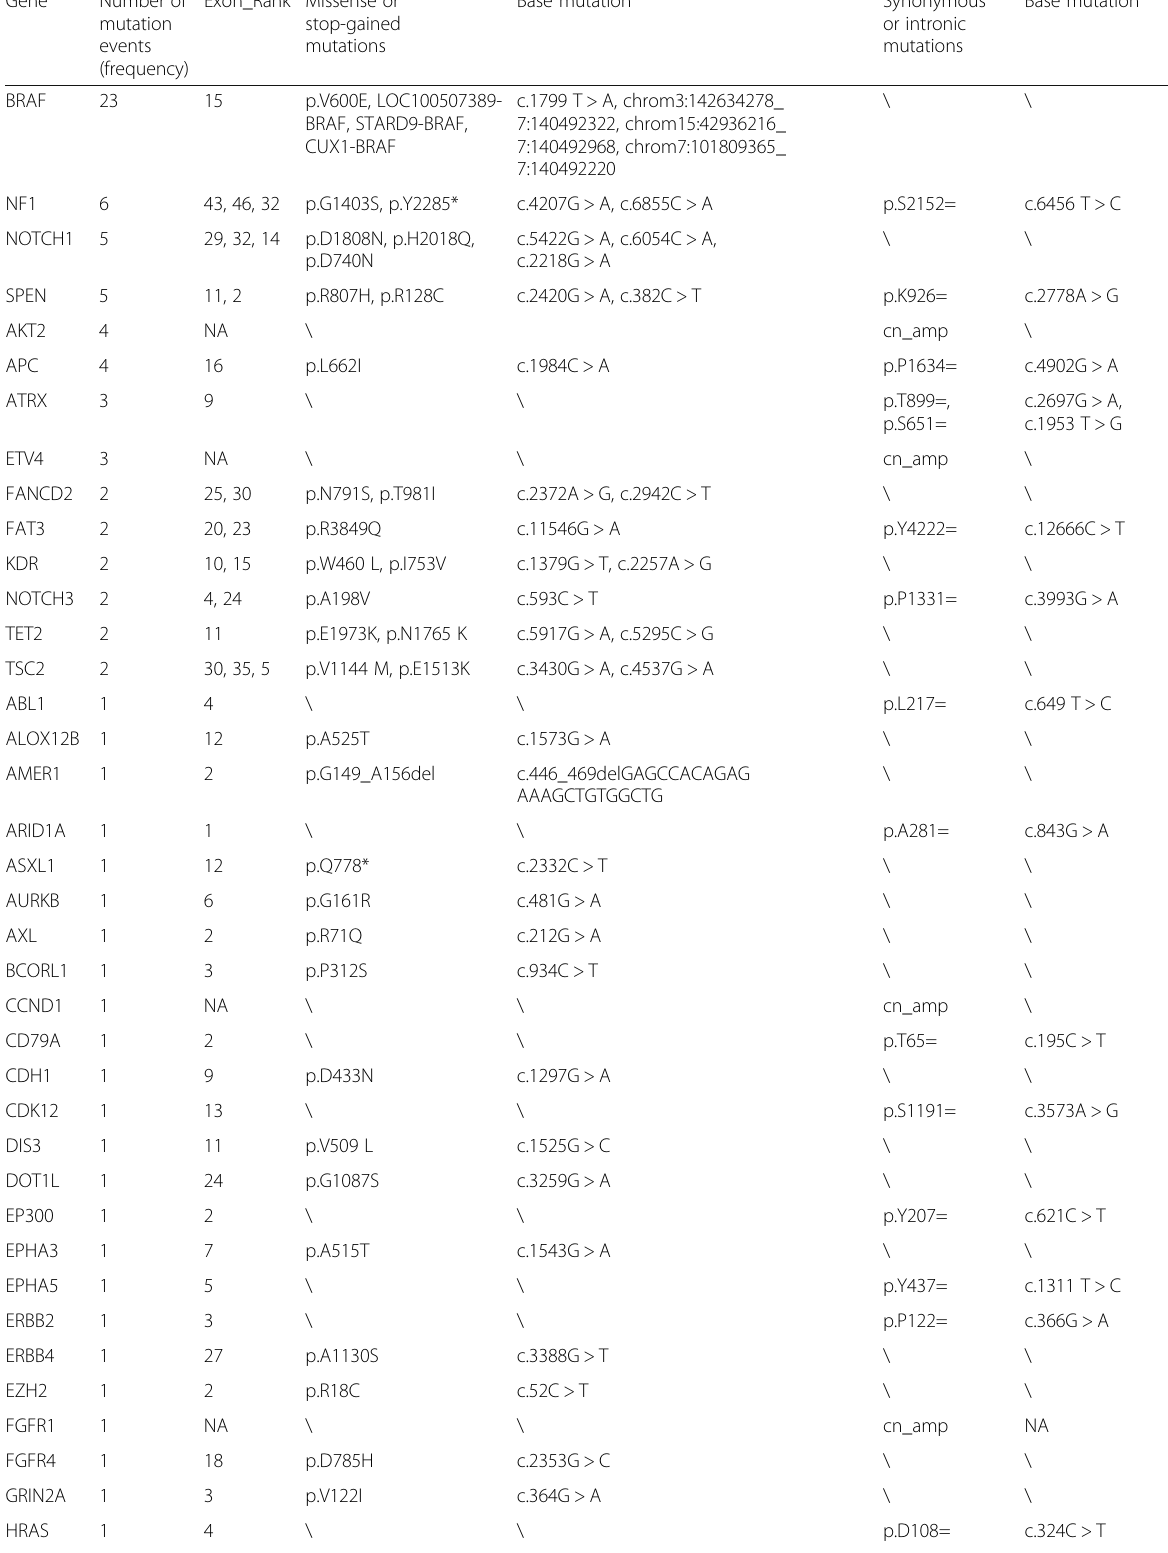
Table 3 Gene altered in